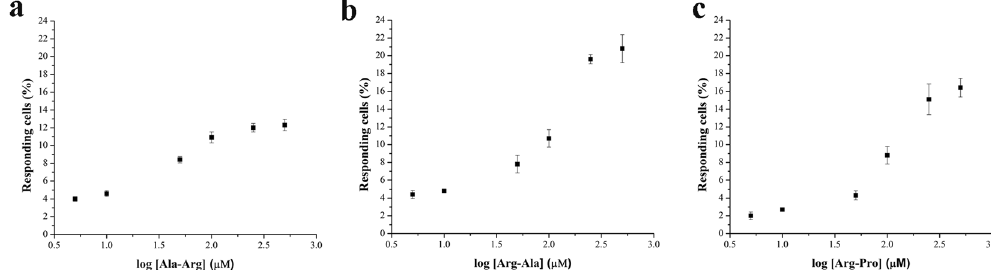
Figure 1. Arginyl dipeptides Ala-Arg ( a ), Arg-Ala ( b ), and Arg-Pro ( c ) elicited responses in a concentration- dependent manner. HBO cells were stimulated with six different dipeptide concentrations: 5, 10, 50, 100, 250, and 500 µ M (x-axis) and each point represents the average of data collected from independent experiments. The percentage of cells responding were measured by intracellular Ca 2 + changes (y-axis). Each experiment was performed eight times. For each panel the peak number of responding cells/total cells examined were: 184/582 ( a ), 92/276 ( b ) and 110/430 ( c